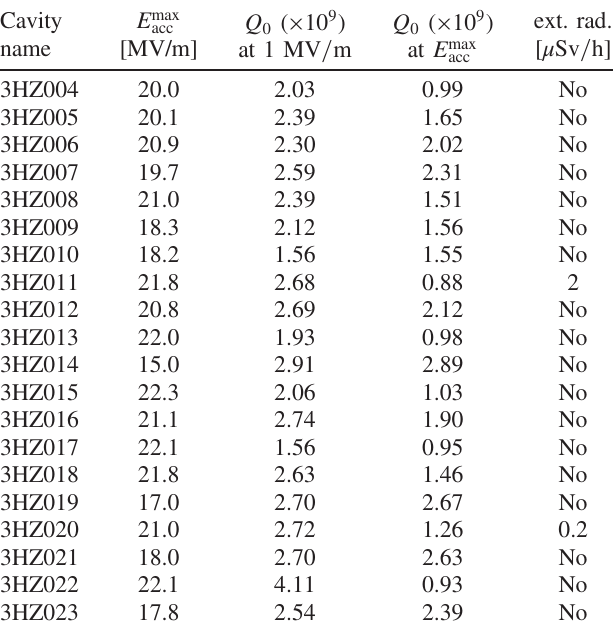
TABLE I. Performances of 3.9 GHz cavities.